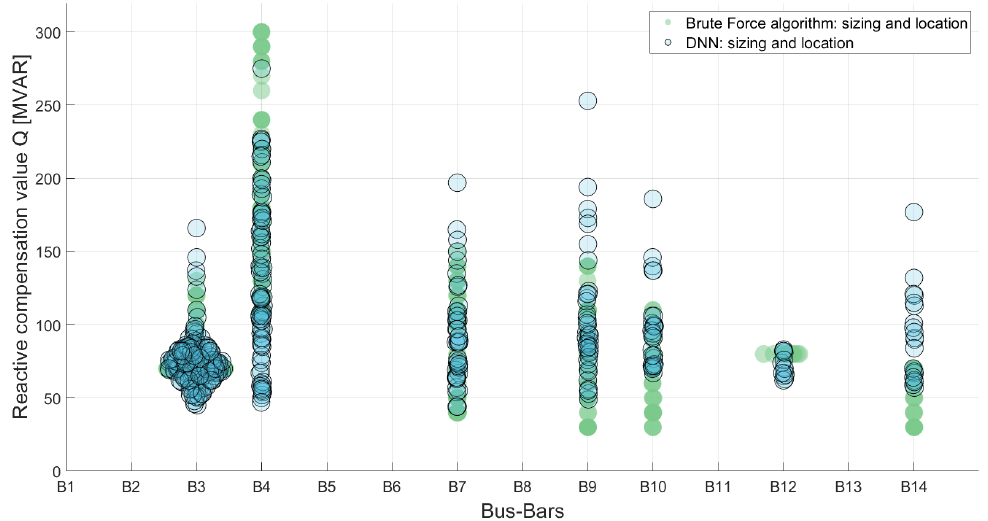
Figure 3. Sizing and location results: DNN vs. brute force algorithm—IEEE 14